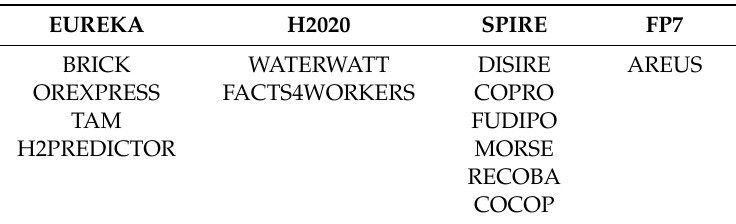
Table A2. List of acronyms of identified other European Funding Projects covering aspects of digitalization in the steel industry.